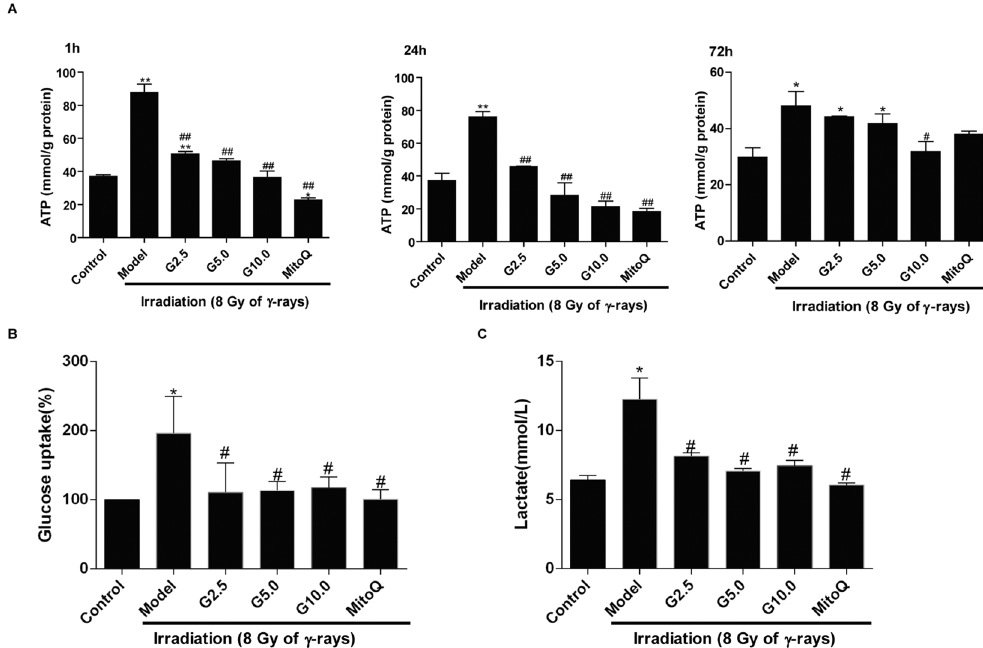
Figure 5. Treatment with GSP reduced the concentration of cellular ATP in irradiated HFL1 cells. HFL1 cells were pre-treated with GSP (2.5, 5, 10 μ g/ml) or MitoQ (200 nmol/L) for 24 h before irradiation, and the cellular ATP content was determined at 1 h and 24 h after irradiation. Data are expressed as the mean ± SEM of three independent experiments. * P < 0.05 and ** P < 0.01 versus control group. ## P < 0.01 versus model